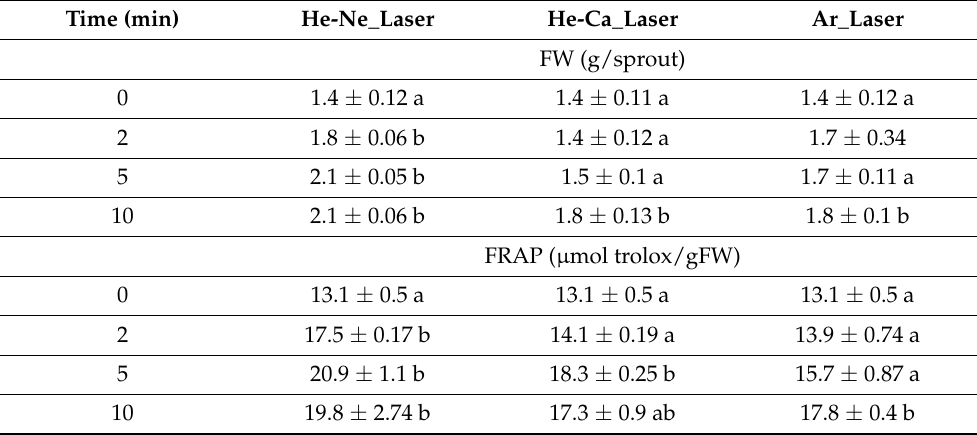
Table 1. Effect of laser treatment on responses of sprouts in terms of plant fresh weight and antiox- idant capacity (ferric reducing antioxidant power, FRAP). Helium-neon (632 nm, 5 mW), helium cadmium (442 nm, 16 mW), and argon (514 nm, 8 mW) were applied at different exposure times (0, 2, 5 and 10 min). Data are represented by means ± standard errors. Different small letters (a, b . . . ) above bars indicate significant differences between means at p <